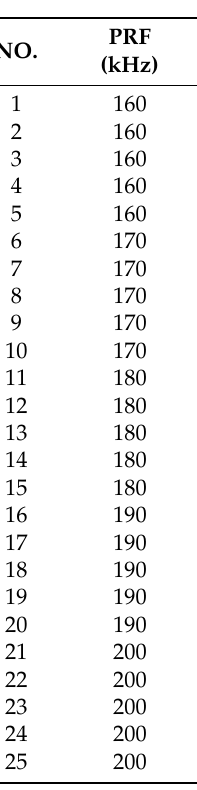
Table 4. Experimental results L 25 (5 3 ) orthogonal